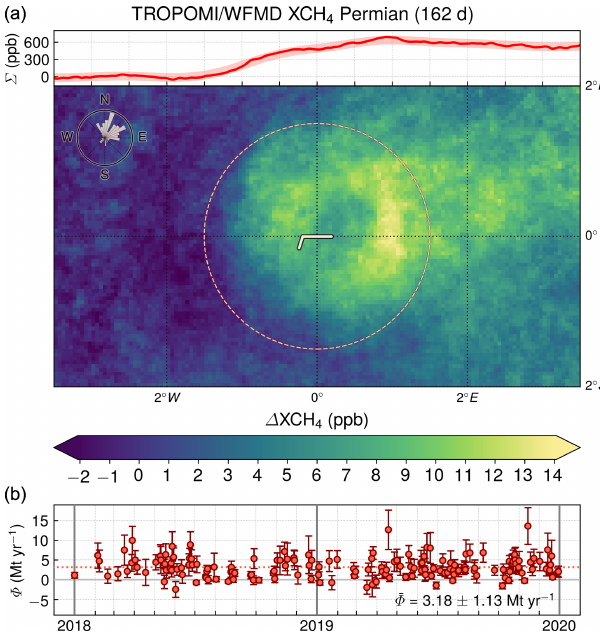
Figure 4. Averaged enhancement distribution with associated in- tegrated enhancement along the meridional sections (a) and daily emission estimates (cid:56) (b) for the Permian Basin. The coordinates of the pivotal point are 31 . 85 ◦ N and 102 . 75 ◦ W; the radius of the circle highlighting the approximate basin extent is 166 . 5km, corre- sponding to 1 . 5 ◦ after the coordinate transformation. The daily (cid:56) values are used to determine the mean emission (cid:56) , which corre- sponds to a fugitive emission rate of 1 . 3 ± 0 . 5%. The distribution of the associated original daily wind directions (defined as the direc- tion in which the wind blows) can be seen in the overlaid wind rose in the upper left